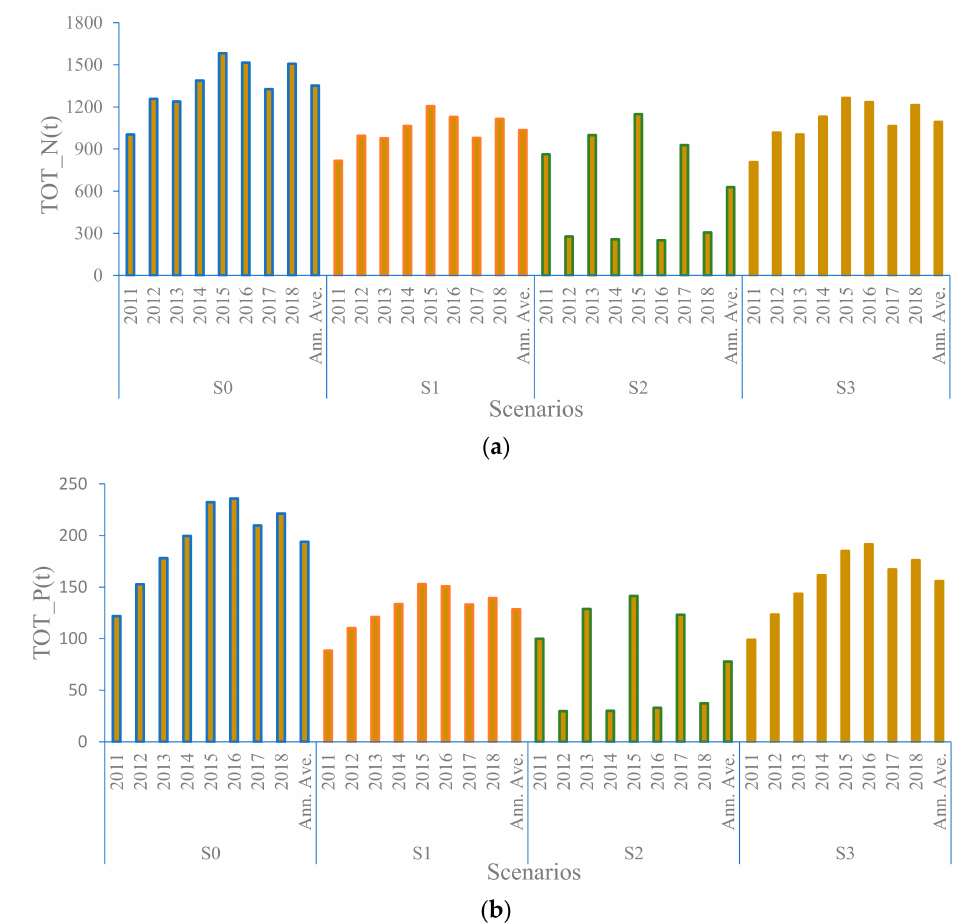
Figure 9. TOT_N ( a ) and TOT_P ( b ) pollution load of each scenario. In each scenario as shown in Table 6, the load of the orchard is medium; the load of rice land and dry land is relatively high, and the load of forest and grass land is relatively low. The order of annual average loss load of nitrogen and phosphorus of agricultural land per unit area is: dry land > rice land > orchard > grass land >